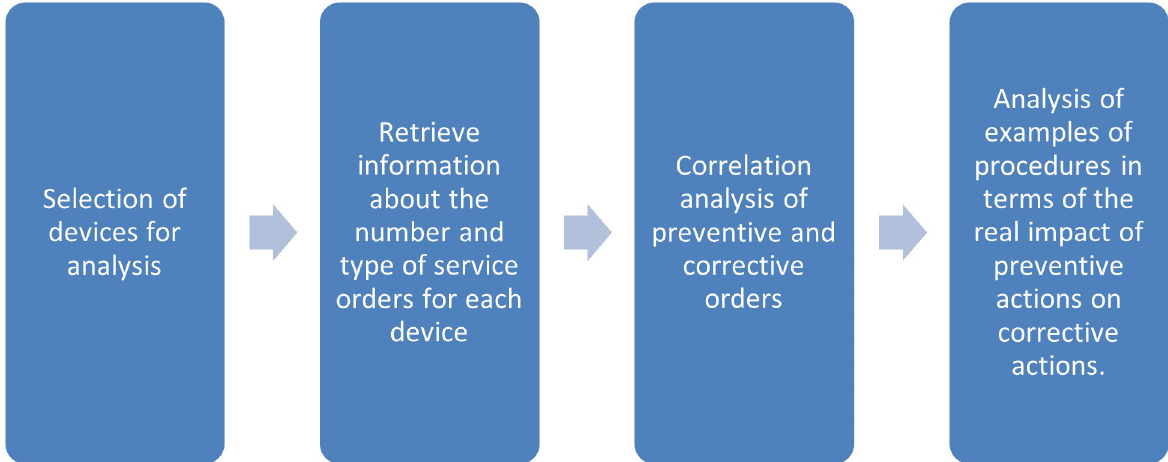
Fig 3. Stages of the study using data from SAP